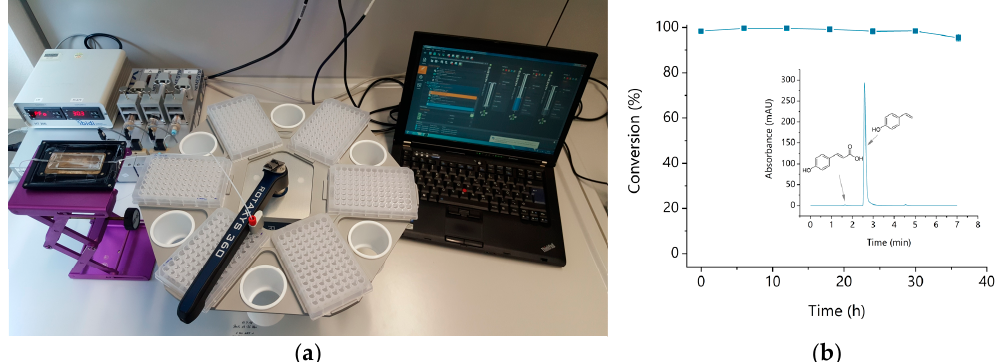
Figure 6. Continuous flow, biocatalytic production of p ‐ hydroxystyrene using PAD hydrogel ‐ loaded